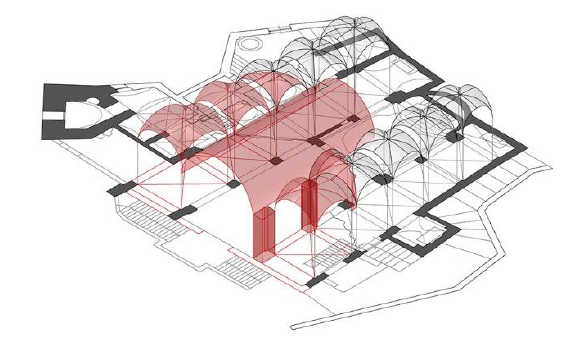
Figure 8. Digital reconstruction of Assunta’s Cathedral vaults